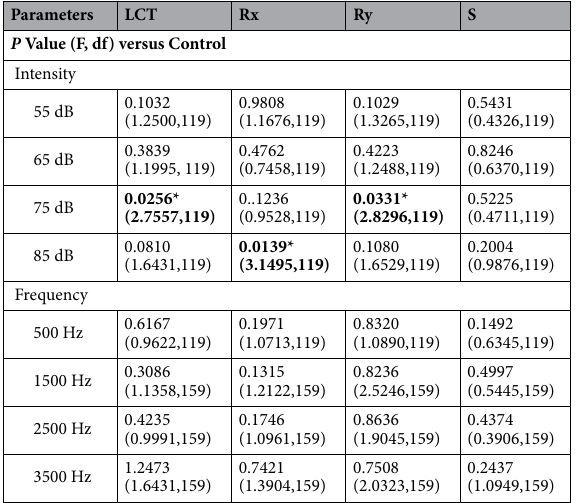
Table 1. P values between the control and noise stimulation groups. Data were analyzed by a one-way repeated measure analysis of variance followed by Dunnett’s post hoc correction for multiple comparisons. df, degree of freedom; LCT, length of the COP sway trajectory; Rx, range of the COP sway trajectory in the A/P direction; Ry, range of the COP sway trajectory in the M/L direction; S, COP sway trajectory envelope area. * means p <